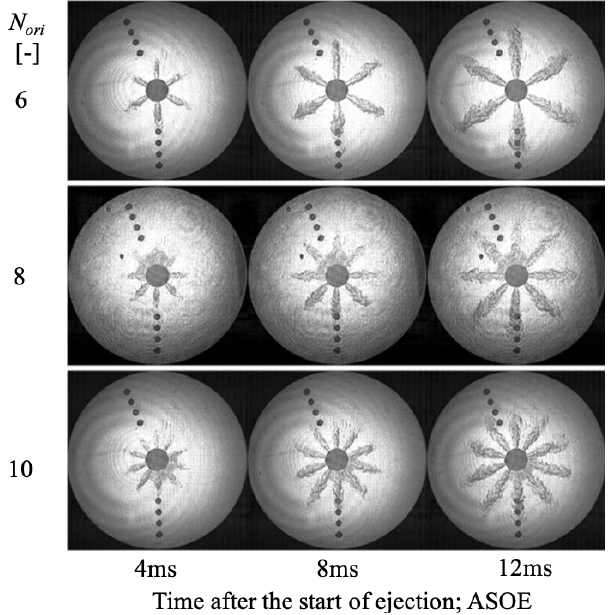
Fig. 10. Shadowgraphs of the different number of orifices (N ori = 6, 8, 10) under “inert”